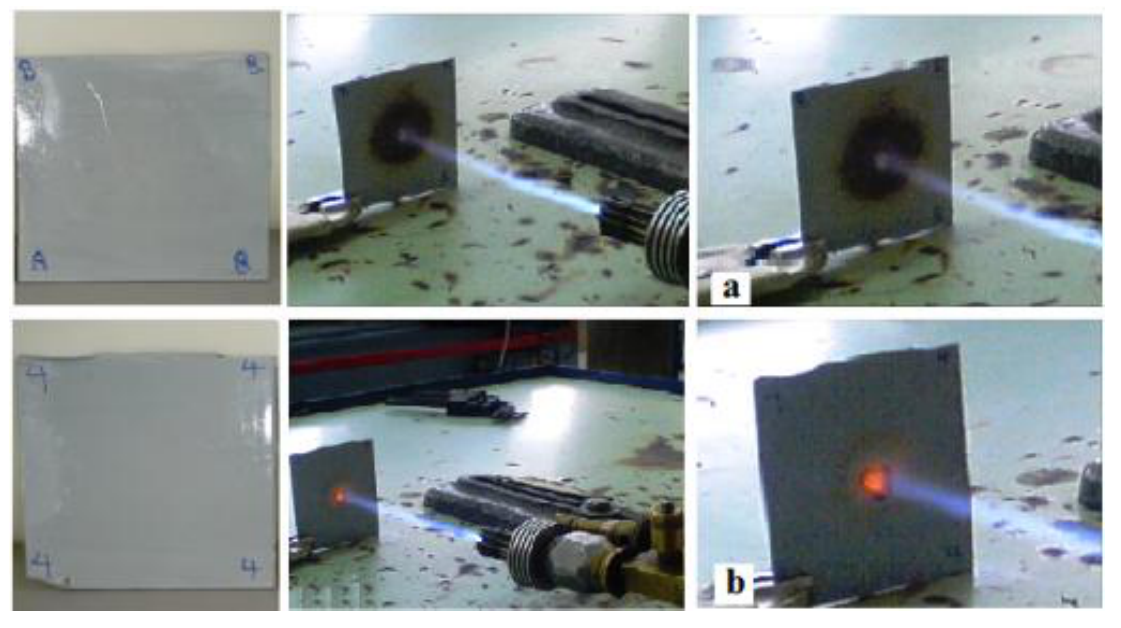
Figure 7. Flammability test for ( a ) neat copolymer; and ( b ) synthesized